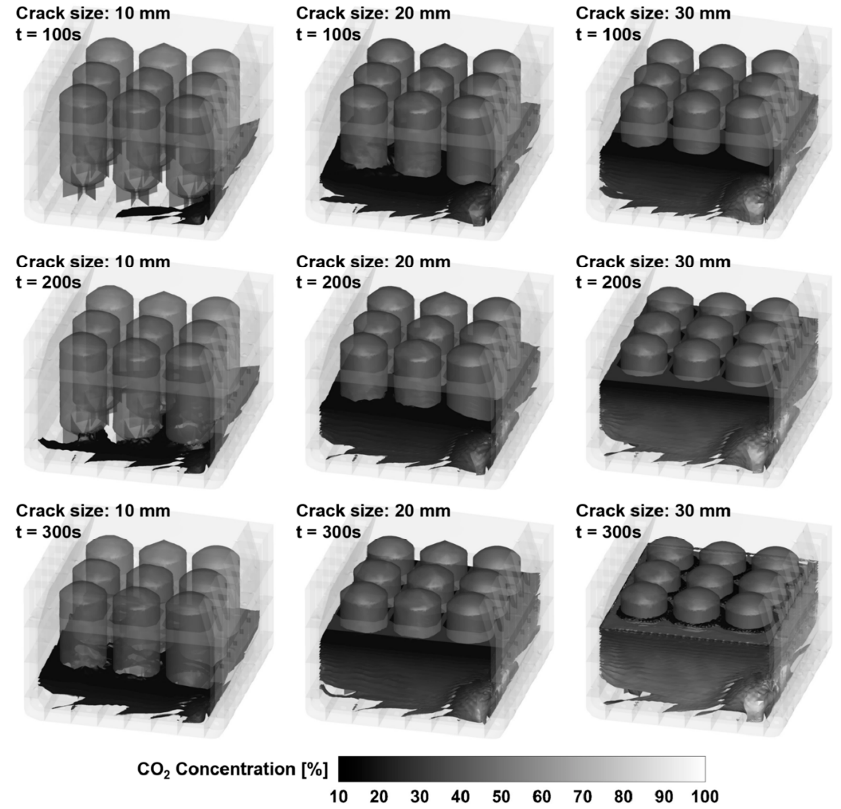
Figure 8. Dangerous volume evolution in the container.